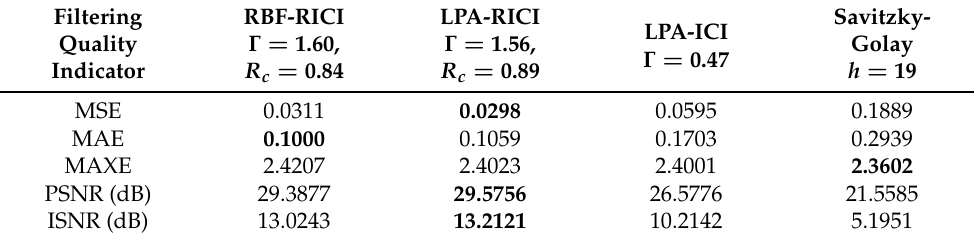
Table 3. Blocks signal (SNR = 10 dB)—Filtering results. Filtering